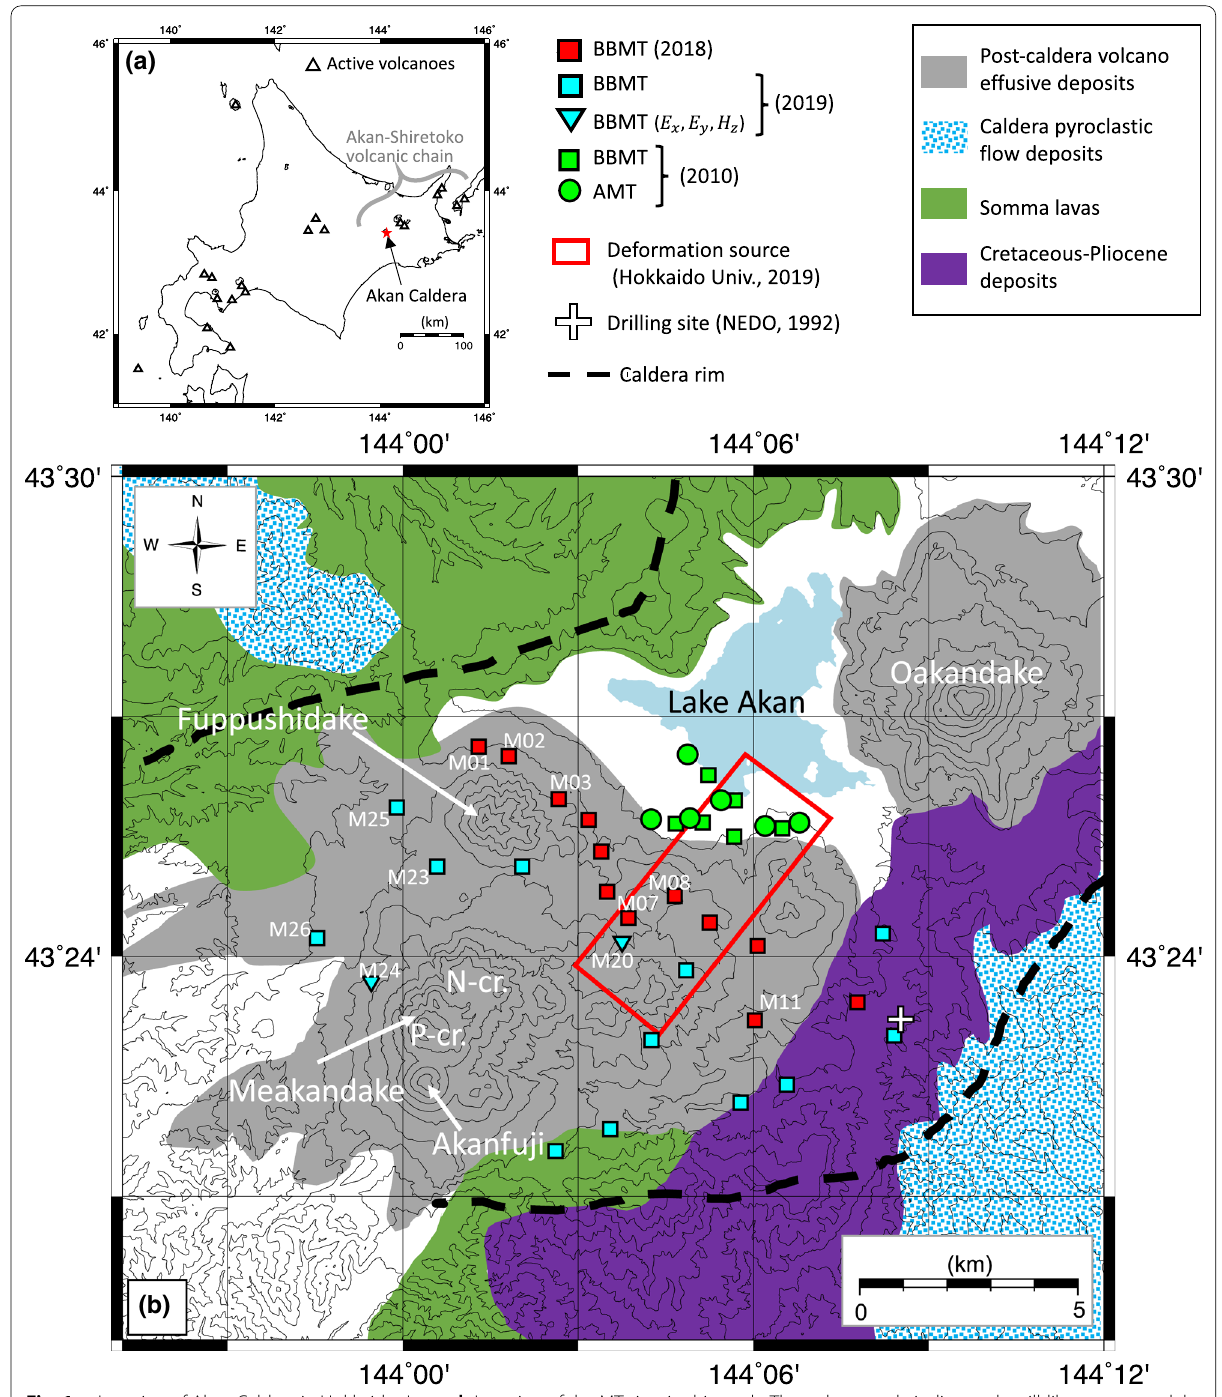
Fig. 1 a Location of Akan Caldera in Hokkaido, Japan. b Location of the MT sites in this study. The red rectangle indicates the sill-like source model of the ground deformation during 2016 and 2017 (Faculty of Science, Hokkaido Univ 2019). The simplified geological map is adapted from the report by Satoh